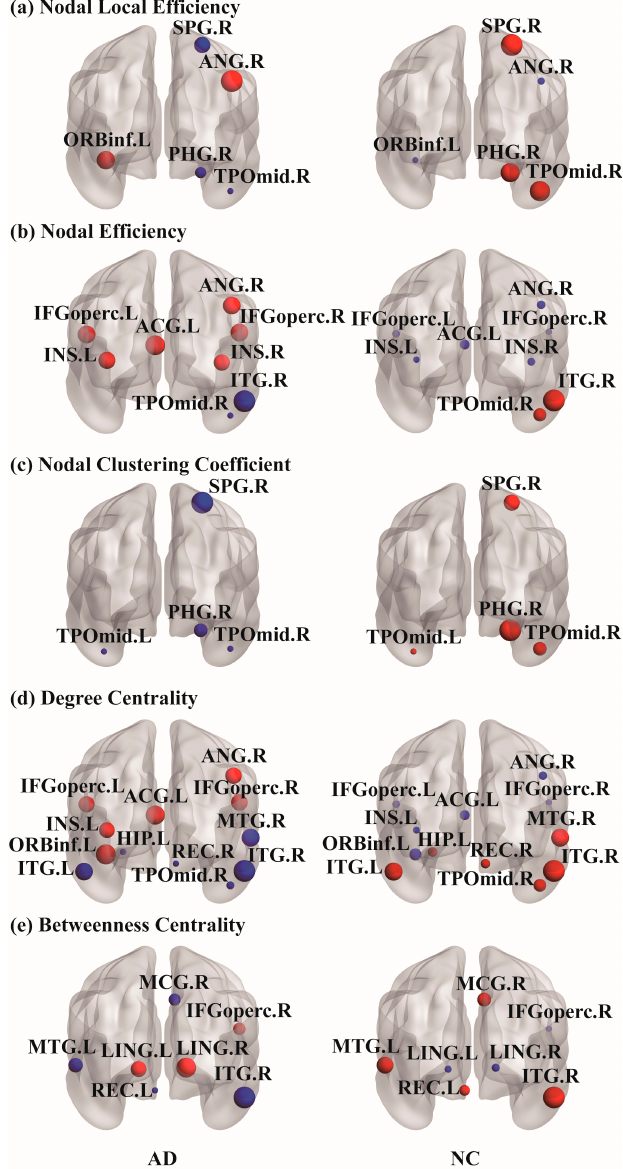
Figure 4. Plots of regions on the cortical surface area. In AAL90, ( a ) nodal local efficiency, ( b ) nodal efficiency, ( c ) nodal clustering coefficient, ( d ) degree centrality and ( e ) betweenness centrality nodal properties have significant differences between the two groups; p < 0.05 was the statistics of two-tailed independent sample t -test analysis results. When comparing each property, red and blue represent the increase or decrease in node property values. The size of the sphere represents the property value. Using BrainNet Viewer software, nodes are mapped to the cortical surface.